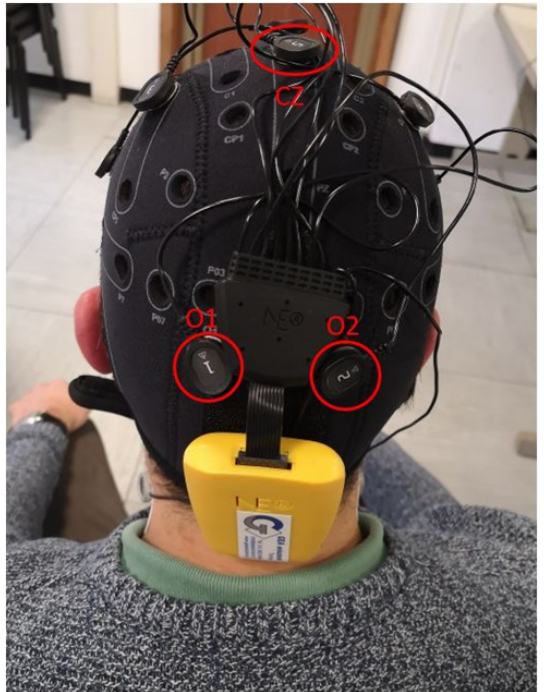
Figure 3. EEG Enobio